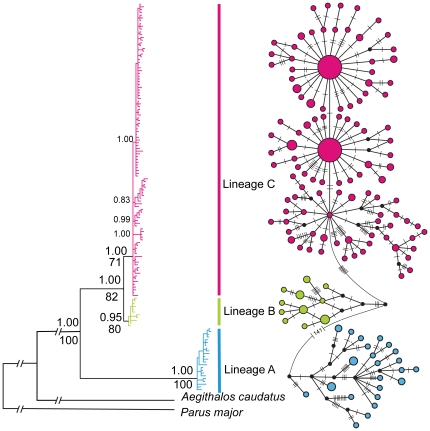
Phylogenetic relationships among haplotypes.The inferred phylogenetic tree and the Major-joining network based on the combined COI, cyt b and ND2 genes. Numbers above tree branches are the posterior probabilities for the BI and bootstrap values for the ML below. Dashes and numbers in the network represent the corresponding mutation steps.